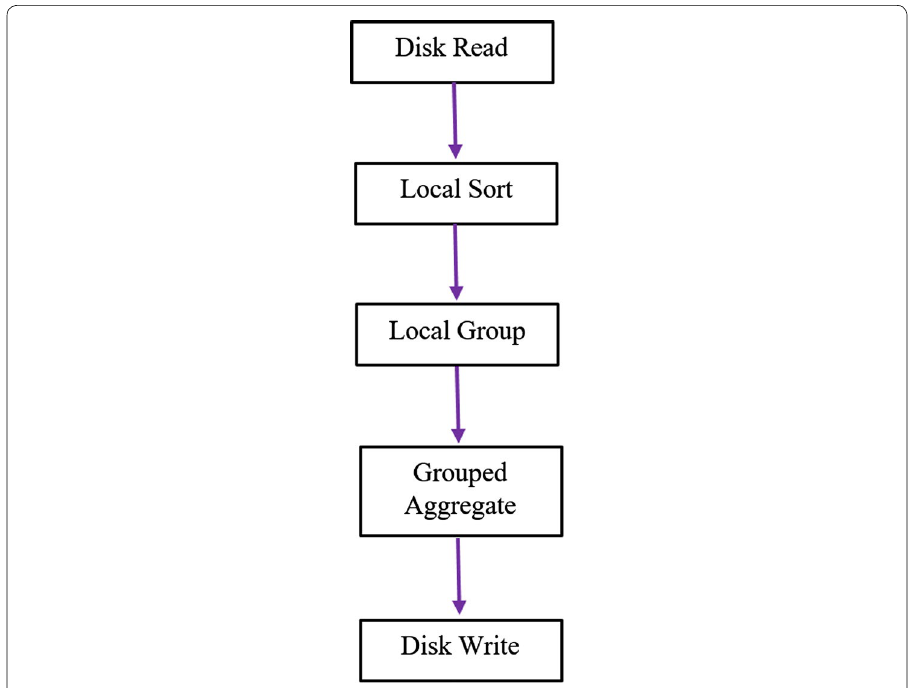
Fig. 1 An example of a DataFlow